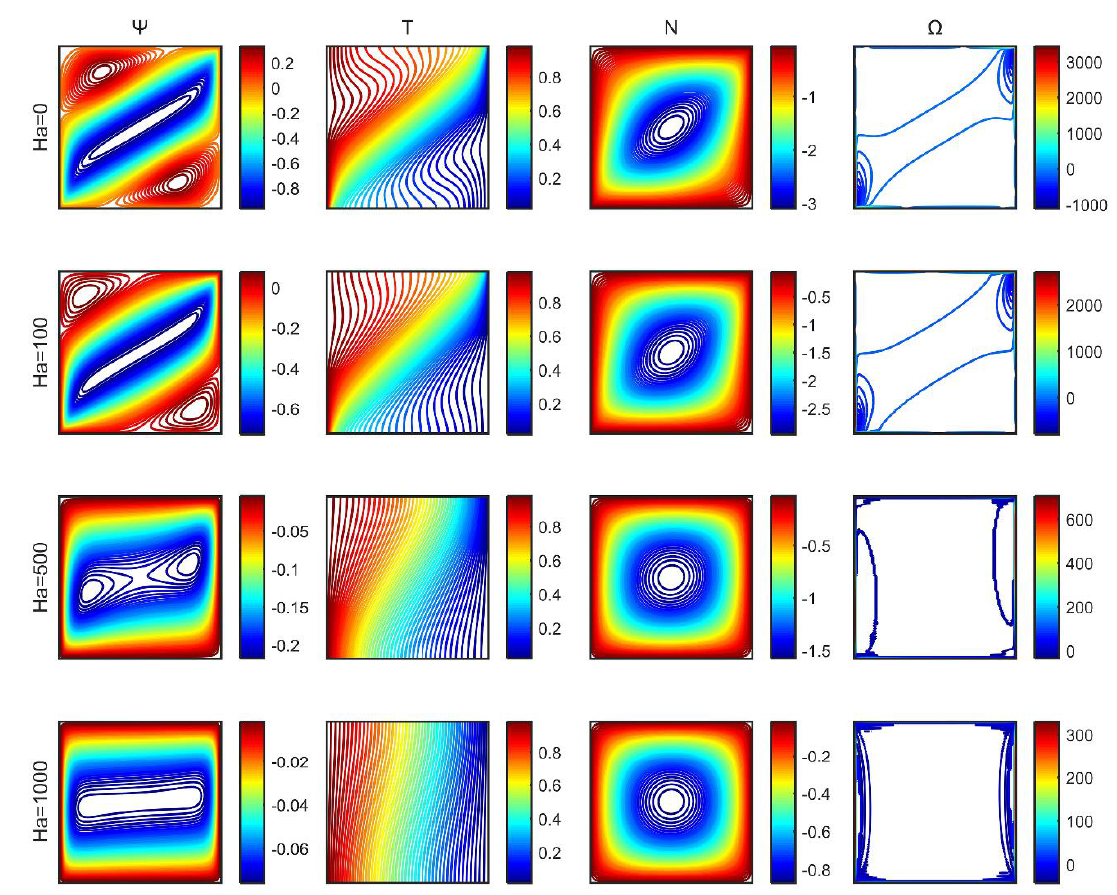
Figure 6. Stream function ( Ψ ), temperature ( θ ), microrotation ( N ), and vorticity ( Ω ) contours for a Figure 6. Stream function ( 𝛹 ), temperature ( 𝜃 ), microrotation ( 𝑁 ), and vorticity ( 𝛺 ) contours for a range of Hartmann range of Hartmann numbers.